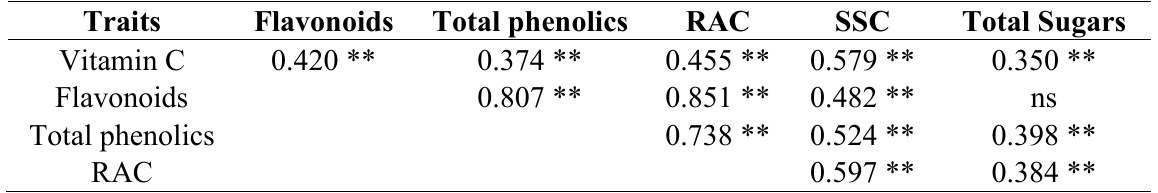
Table 5. Correlation coefficients between some phytochemical traits in the “Venus” × “Big Top”